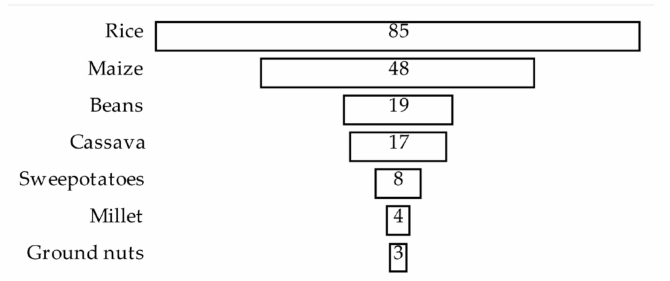
Figure 4. Drop-down scale ranking (by the number of responses) of crops grown by smallholder farmers in the Doho rice scheme, Butaleja District ranked according to importance to the households.